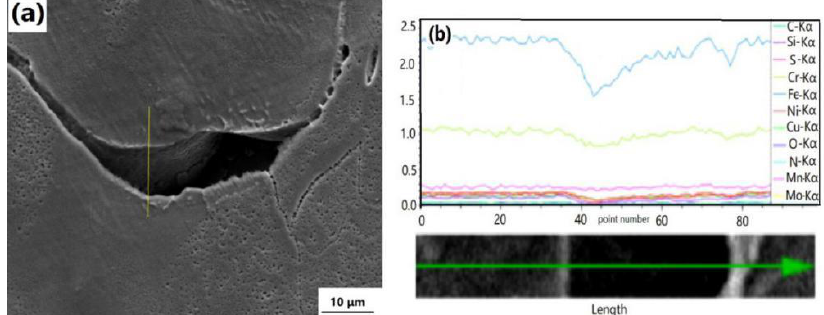
Figure 18. Scanning electron microscopy-energy dispersive spectroscopy (SEM-EDS) elemental line- scan map during hot deformation with a strain rate of 1 s −1 at 1423 K: ( a ) line-scan map and ( b ) line- scan EDS.